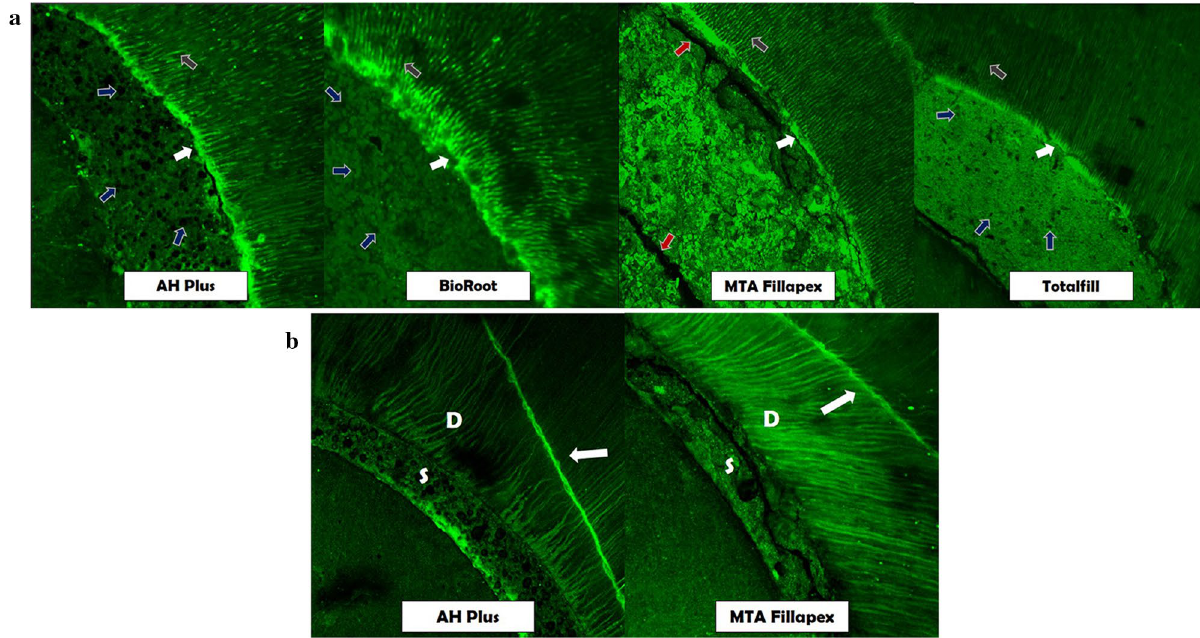
Figure 4. Representative fluorescence-mode CLSM images of sealer-dentin interface demonstrated by Orange G added to the test sealers; ( a ) showing a richly dye-infiltrated layer at the sealer-dentin interface marked with white arrows, sealer penetration inside dentinal tubules marked with grey arrows, porosity of sealers with blue arrows and cracks on sealer mass with red arrows; ( b ) cracks indicated by fluorescent radial lines on dentin (D) marked by white arrows and on the sealer (S) for MTA Fillapex indicated with red